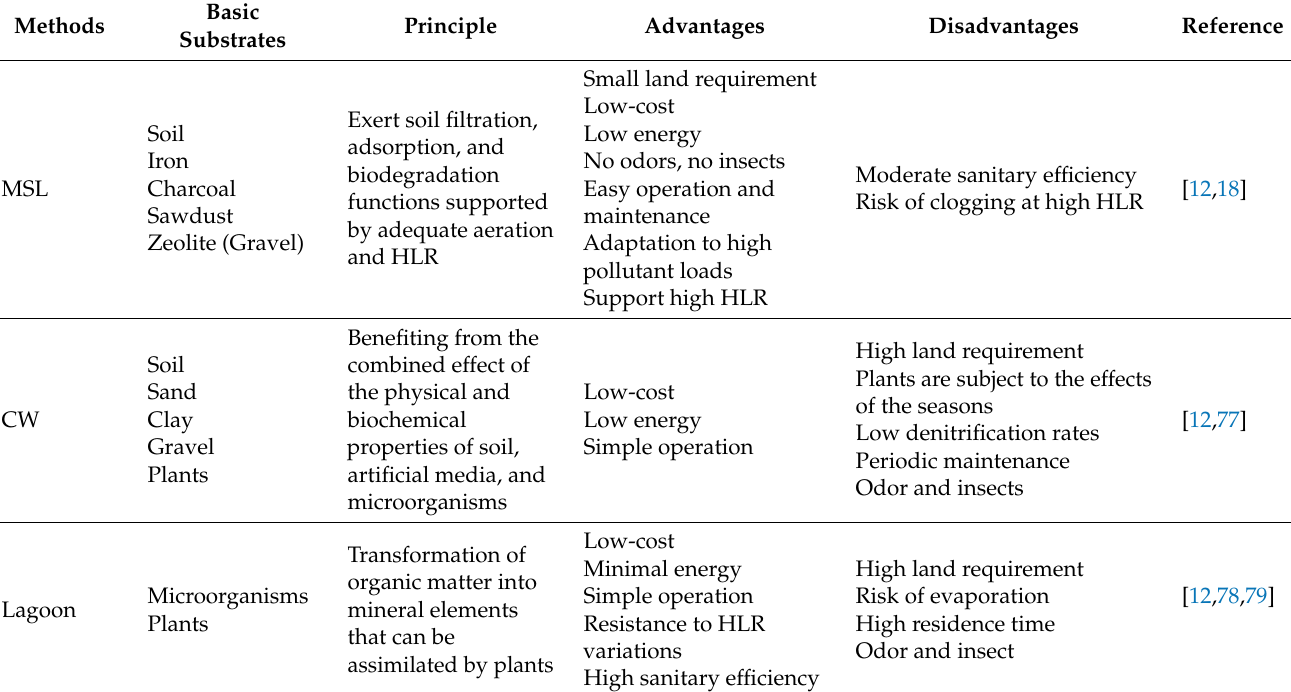
Table 2. Main advantages and disadvantages of various rural sewage treatment